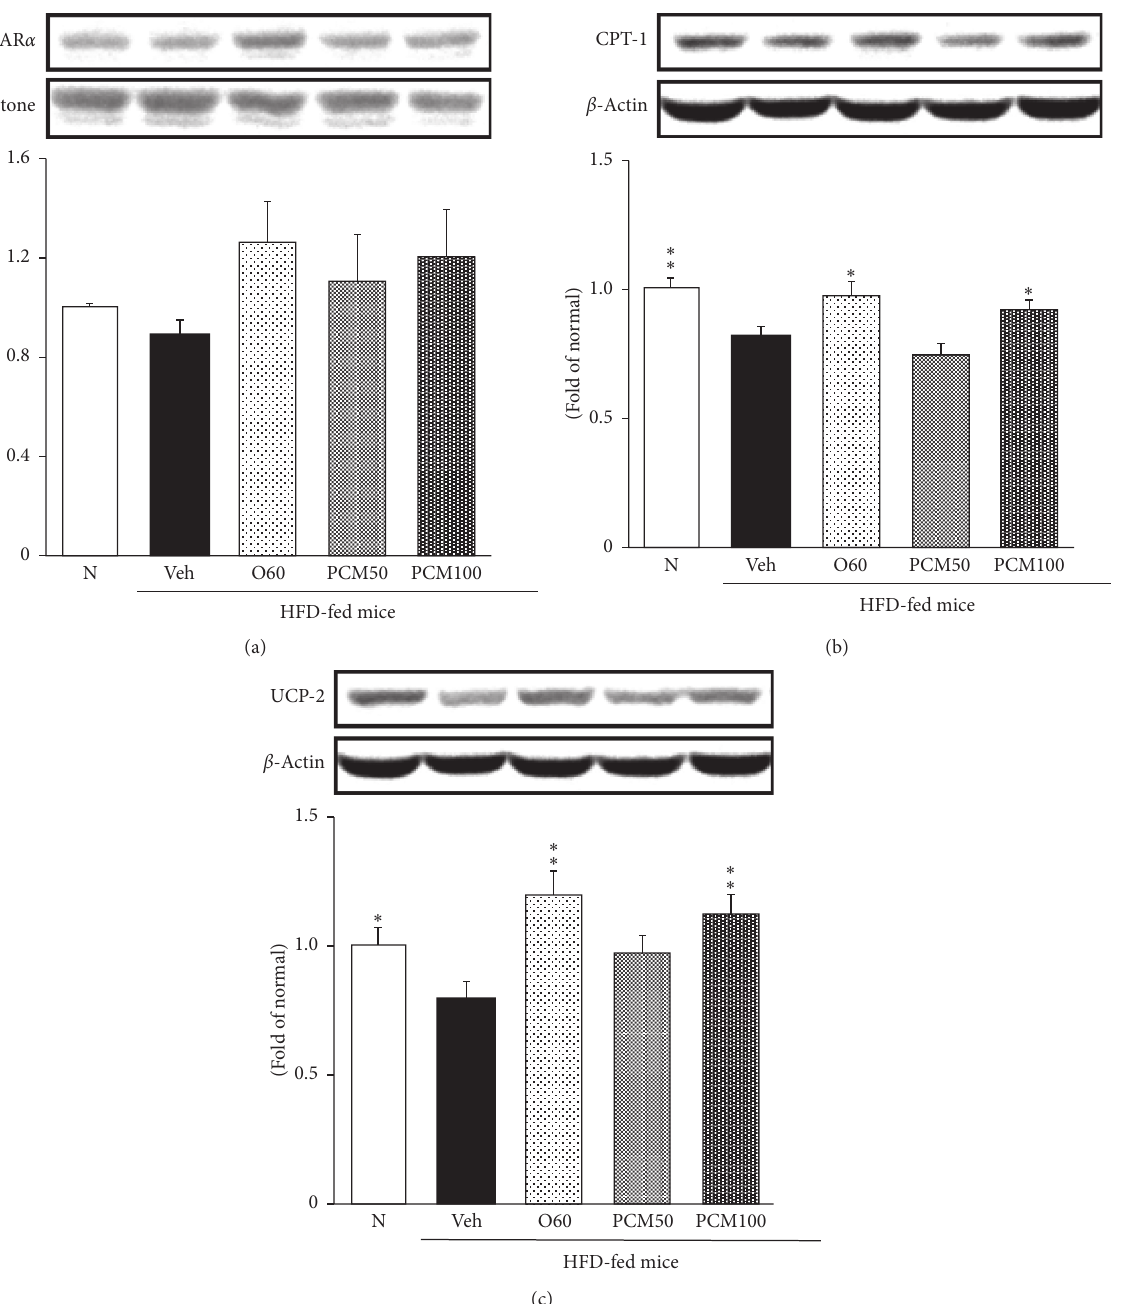
Figure 4: PPAR α (a), CPT-1 (b), and UCP-2 protein (c) expressions in the liver. N, normal mice; Veh, HFD control mice; O60, orlistat 60mg/kg-treated and obese mice; PCM50, PCM 50mg/kg-treated and obese mice; PCM100, PCM 100mg/kg-treated and obese mice. Data are the mean ± SEM, n � 7. Significance: ∗ p < 0.05 and ∗∗ p < 0.01 versus HFD control mice. PPAR α , peroxisome proliferator-activated receptor α ; CPT-1, carnitine palmitoyltransferase 1; UCP-2, uncoupling protein